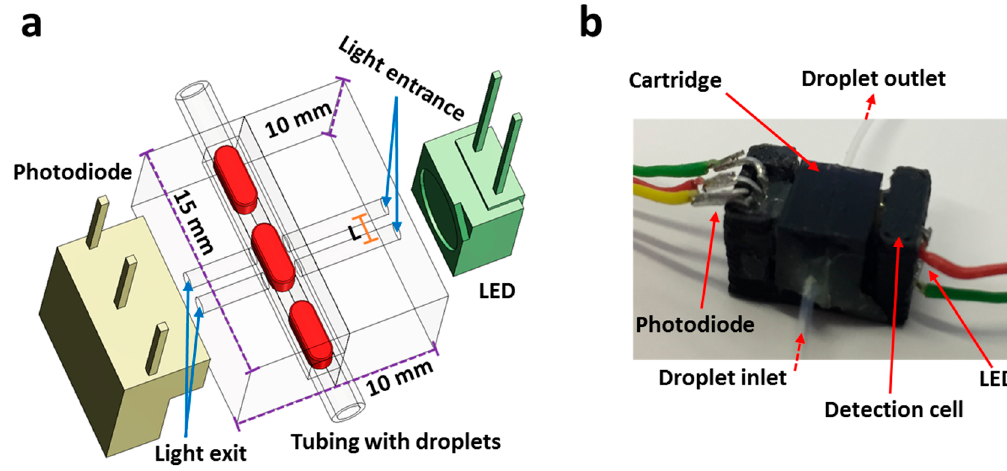
Figure 1. Flow cell: ( a ) Schematic of the optical flow cell showing two holes for light entrance to the channel and light exit to the detector. L is a center-to-center distance between two light paths; ( b ) Snapshot of the fully assembled flow cell.